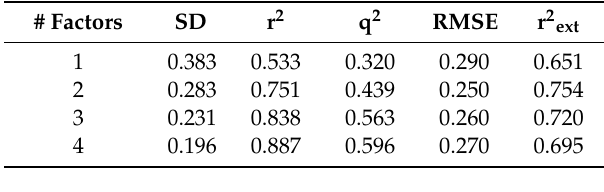
Table 7. Atom based 3D-QSAR statistics.